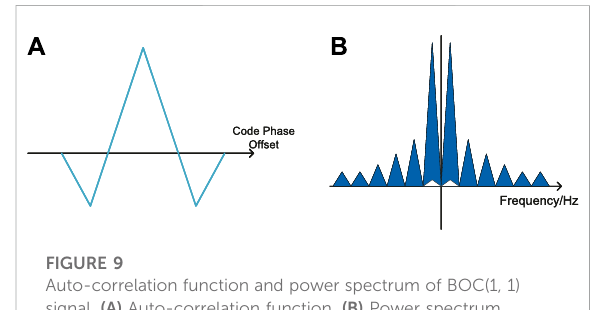
FIGURE 9 Auto-correlation function and power spectrum of BOC(1, 1) signal. (A) Auto-correlation function. (B) Power spectrum.